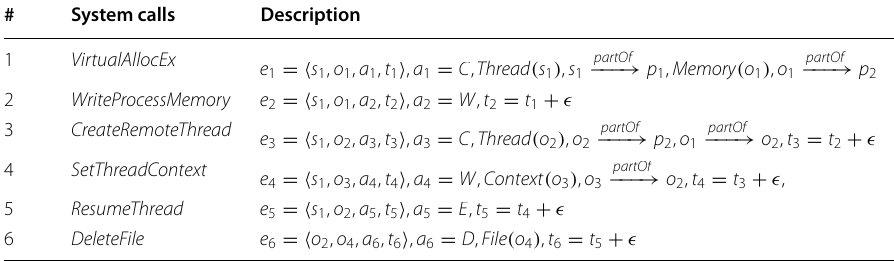
Table 9 Implicit file removal through code injection into process p 2 by process p 1 [16]